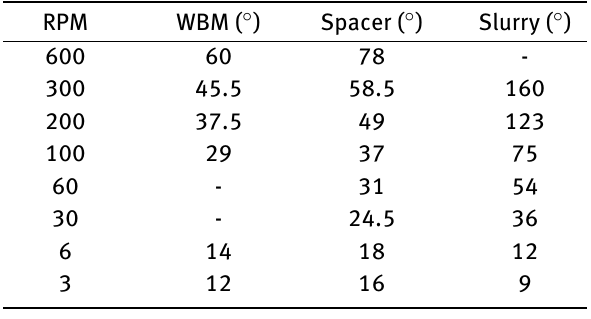
Table 1: Fann Model 35 measurements of three different well con- struction fluids.